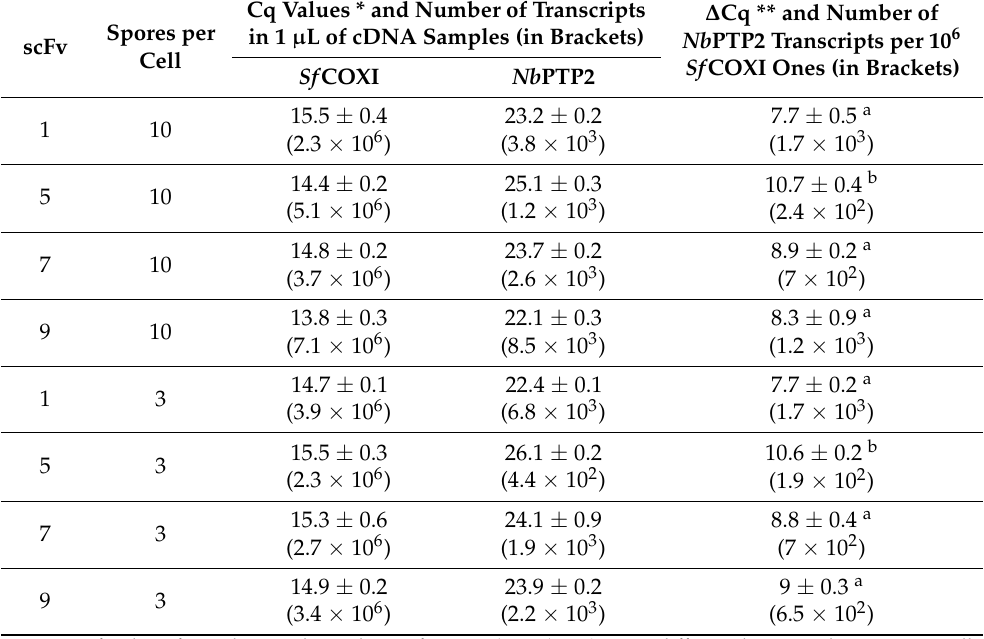
*—mean of values from three independent infections ( n = 9) ± SE; **—different letters indicate statistically significant differences ( p -value < 0.05) between ∆ Cq values in scFv5 and other samples as analyzed by